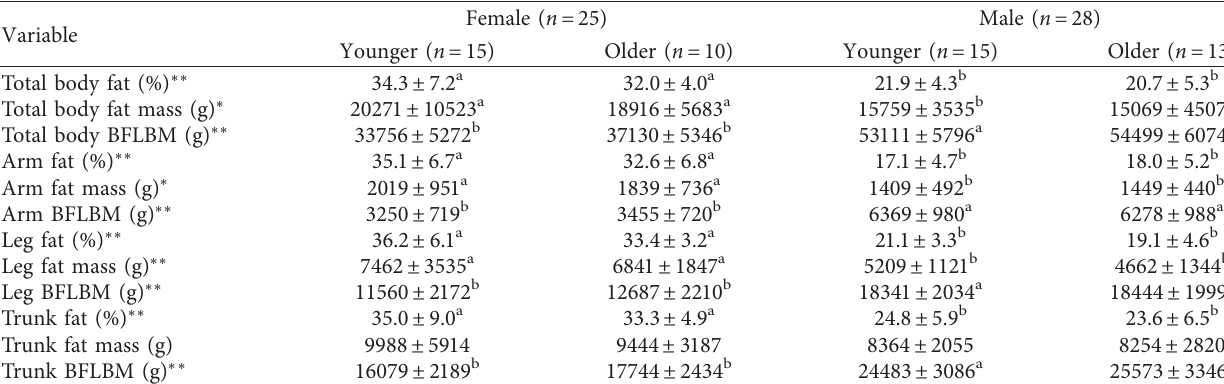
Table 2: Total and regional body composition (mean ±